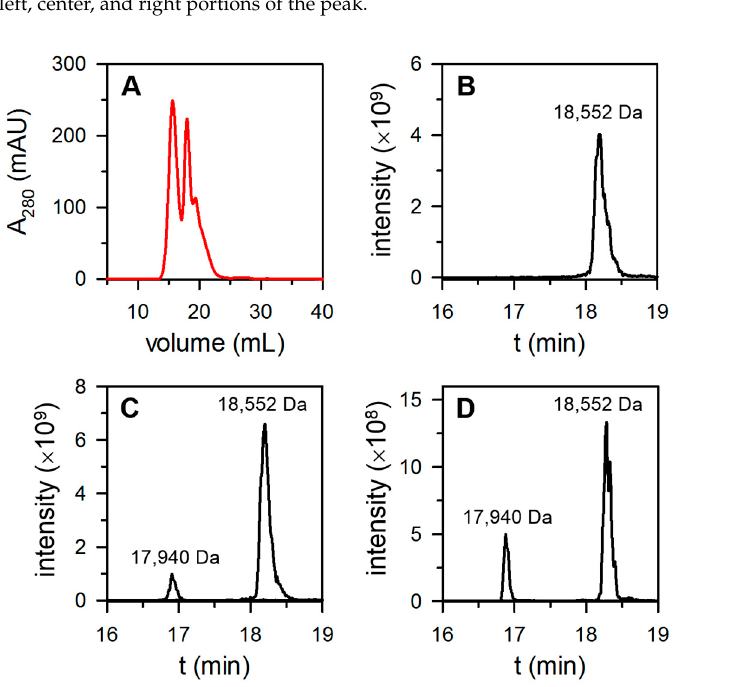
Table 1. The proportion of FtnA and BfrB subunits in Bfr is affected by O 2 availability. %FtnA in Bfr Fraction from Source TM 15Q 21% O 2 10% O 2 2% O 2 Anaerobic 1st peak a 0 2nd peak a 10 ± 1 shoulder a 21 ± 0.6 left b 28 ± 1 30 ± 4 29 ± 1 center b 38 ± 2 45 ± 6 47 ± 2 right b 49 ± 3 59 ± 1 69 ± 2 a Bfr elutes from as Source TM 15Q column in two peaks and a shoulder (e.g., see Figure 3A). b Bfr elutes from a Source TM 15Q column in a single broad peak (e.g., see Figure 4A); left, center, and right denote fractions from the left, center, and right portions of the peak.